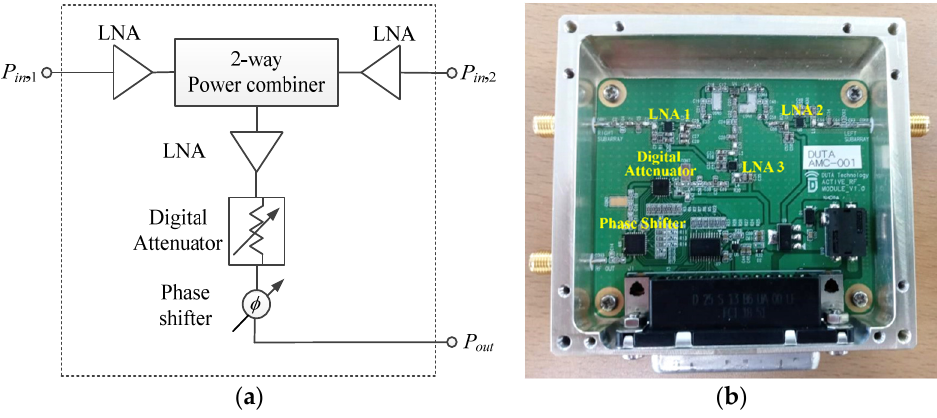
Figure 6. ( a ) Block diagram of the beamforming Rx RF module (BF-RFMs) and ( b ) implementa- tion.